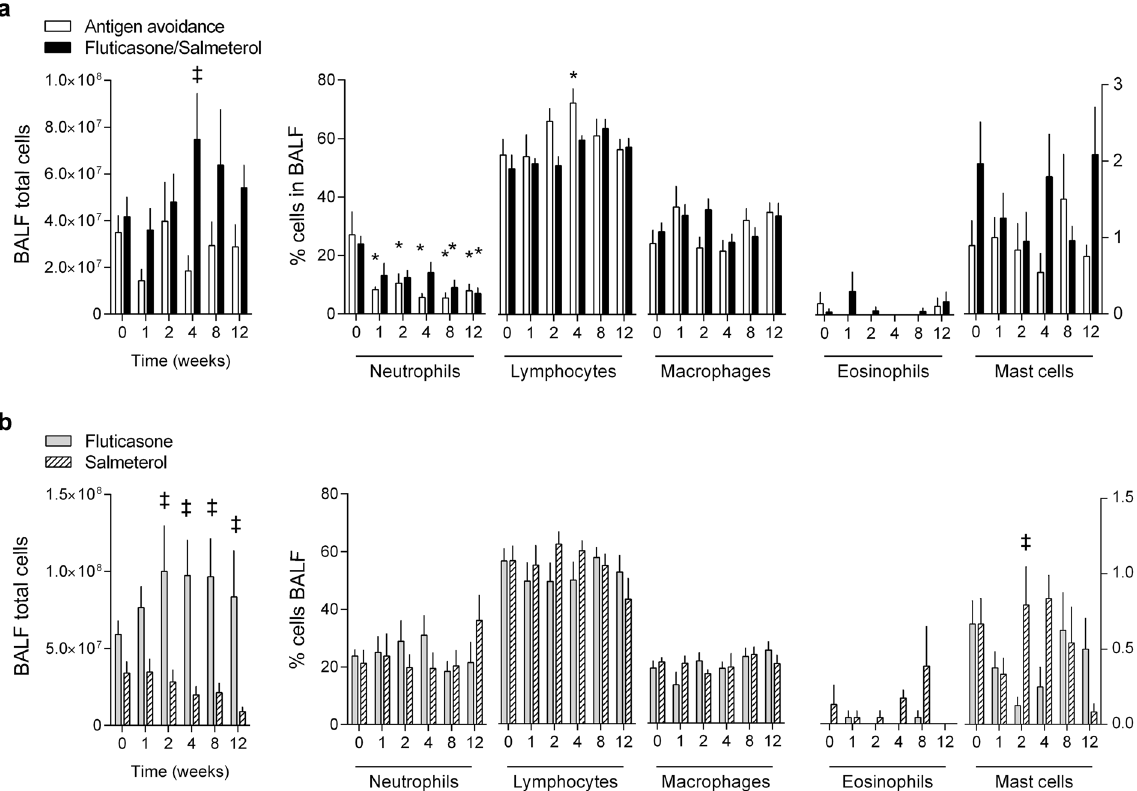
* different from baseline of the same group (p < 0.05); ‡Difference between groups at the time point indicated (p < 0.05). BALF: bronchoalveolar lavage fluid